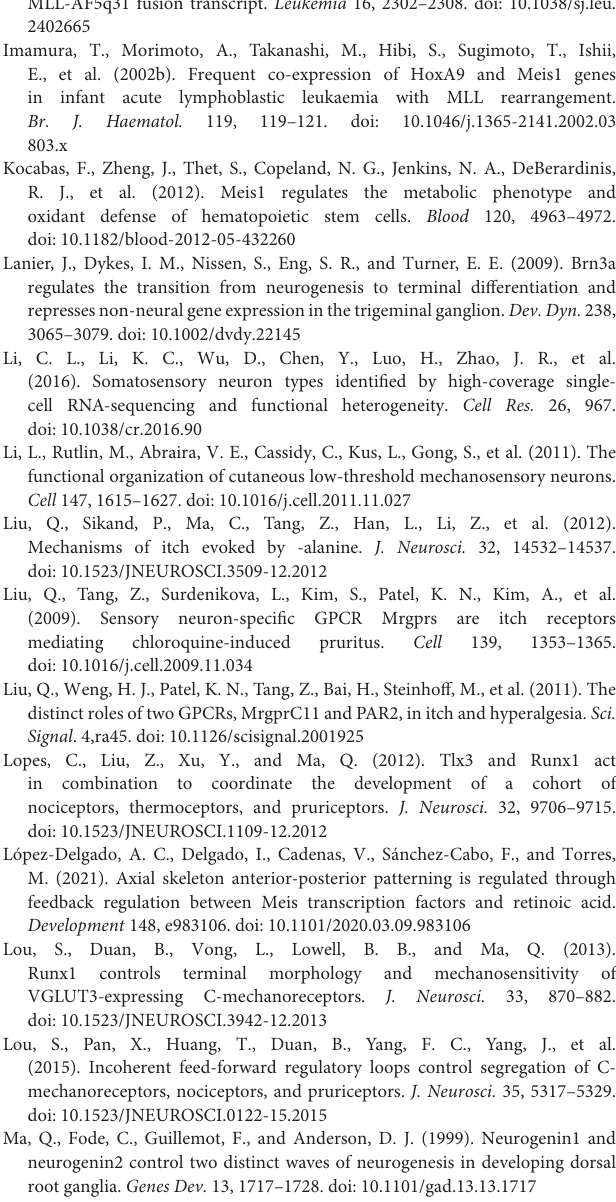
or L4/L5 DRGs from 3 pairs of P60 Meis1cko and control mice. The expression of MrgprD (A–F) , MrgprA3 (G–L) and Nppb (S–X) was not significantly altered in cervical and thoracic DRGs. (M–R) The expression of Cysltr2 in the thoracic DRG was significantly decreased from 6.9 ± 0.6 in control mice to 5.0 ± 0.5 in Meis1cko mice ( n = 3 mice per group, p = 0.014), but a significant change was not observed in the cervical DRG. Error bars represent the SEM. Significant differences were determined using unpaired Student’s t test: ∗ p < 0.05, ns, Not significant. Scale bar: 50 µ m. Supplementary Figure 6 | Expression of a subset of known cluster-specific markers in Meis1cko and control DRGs at P0.5 and P7.5. ISH with the indicated probe on lumbar DRG sections from 3 pairs of Meis1cko and control mice at P0.5 (A–I) and P7.5 (J–R) . Error bars represent the SEM. Significant differences were determined using unpaired Student’s t test: ns, Not significant. Scale bar: 50 µ